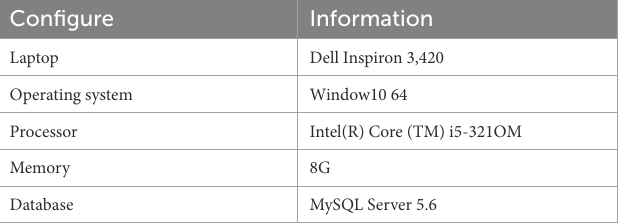
TABLE 1 Settings for the test